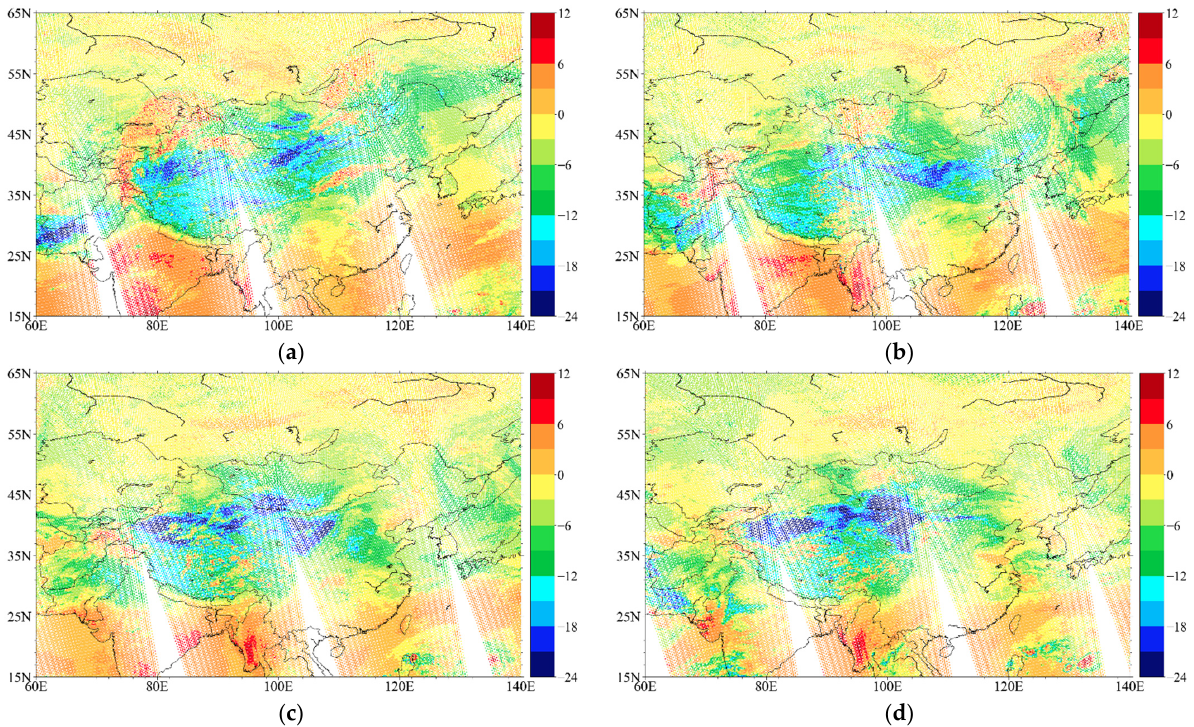
Figure 10. The CrIS SESI image of 14–17 March 2021. ( a ) 14 March 2021; ( b ) 15 March 2021; ( c ) 16 March 2021; ( d ) 17 March 2021.